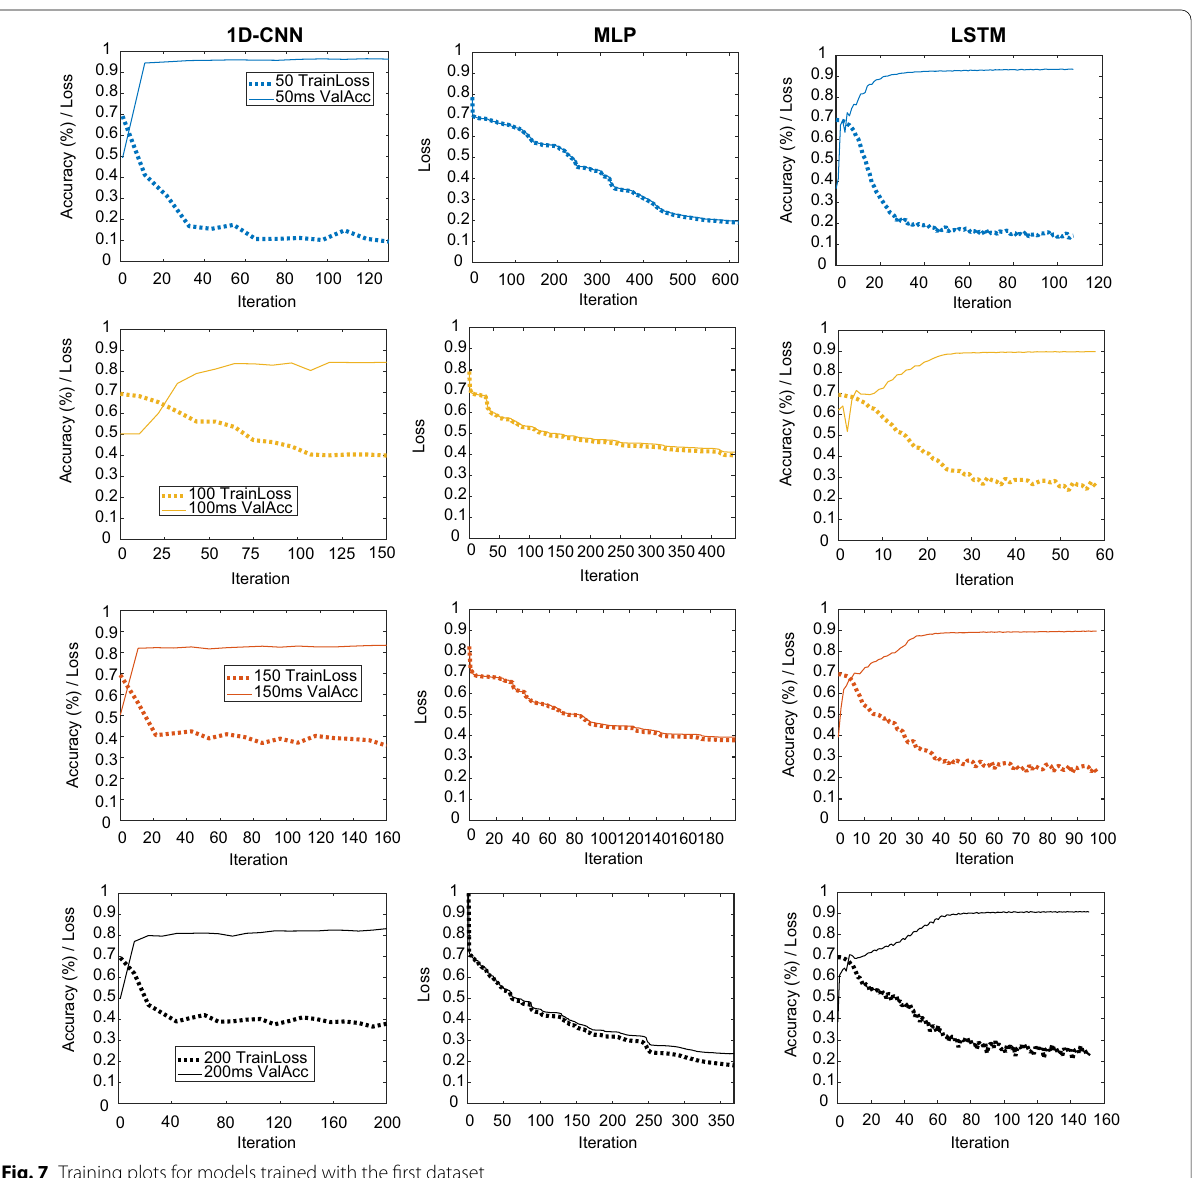
The first column is the rat identification, column 2 and 3 the selected two best channels of the mPFC recordings, and 4 and 5 of the MD recordings. Finally, column 6 shows the range of artifact-free epochs during walking and column 7 during resting, respectively [74]